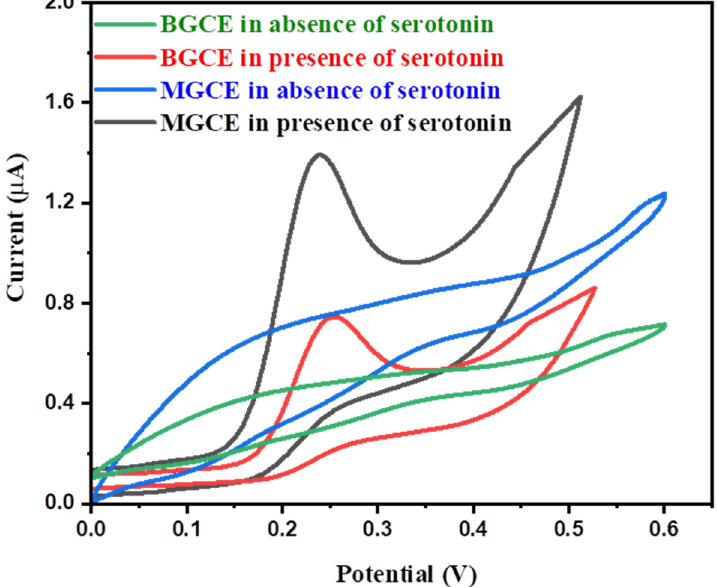
Figure 4. CVs of BGCE and MGCE in absence and presence of 2 µ M serotonin in 0.1 M PBS (pH = 7.0) at scan rate of 50 mV/s.